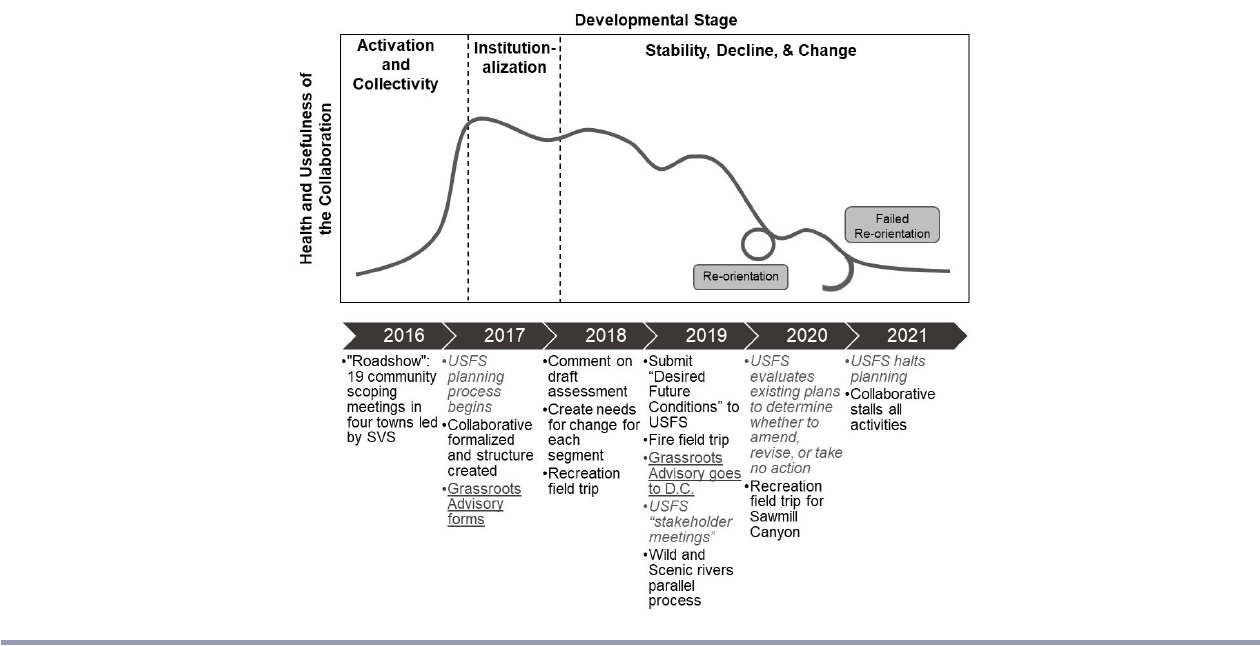
Fig. 2. Development trajectory of the Central Idaho Public Lands Collaborative (above). Salmon-Challis National Forest planning timeline of key activities of the United States Forest Service (USFS), the Collaborative, and the Grassroots Advisory (below). Development trajectory figure adapted from Ulibarri et al. (2021). Discussion of the concept of health and usefulness of a governance process can be found in Imperial et al.